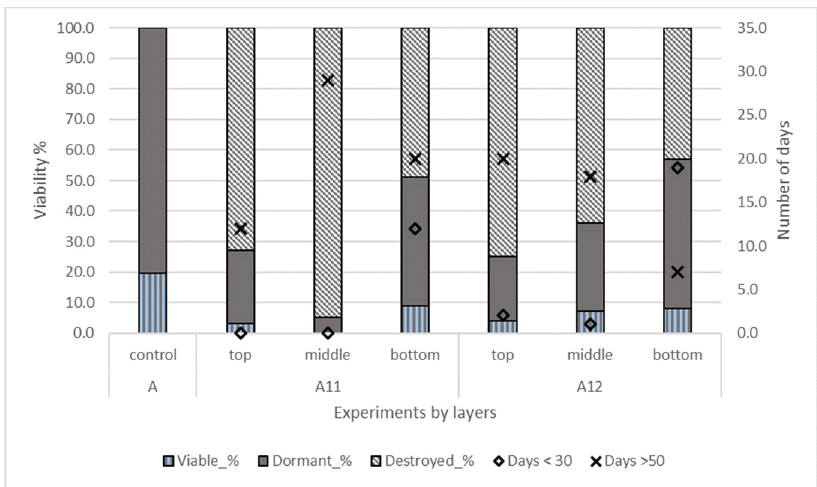
Figure 3. Proportion of viable, dormant and destroyed L. polyphyllus Lind. seed after windrow (A11, A12) composting and control shown separately for compost layers (top, middle and bottom). Number of days < 30 °C and days > 50 °C are presented.